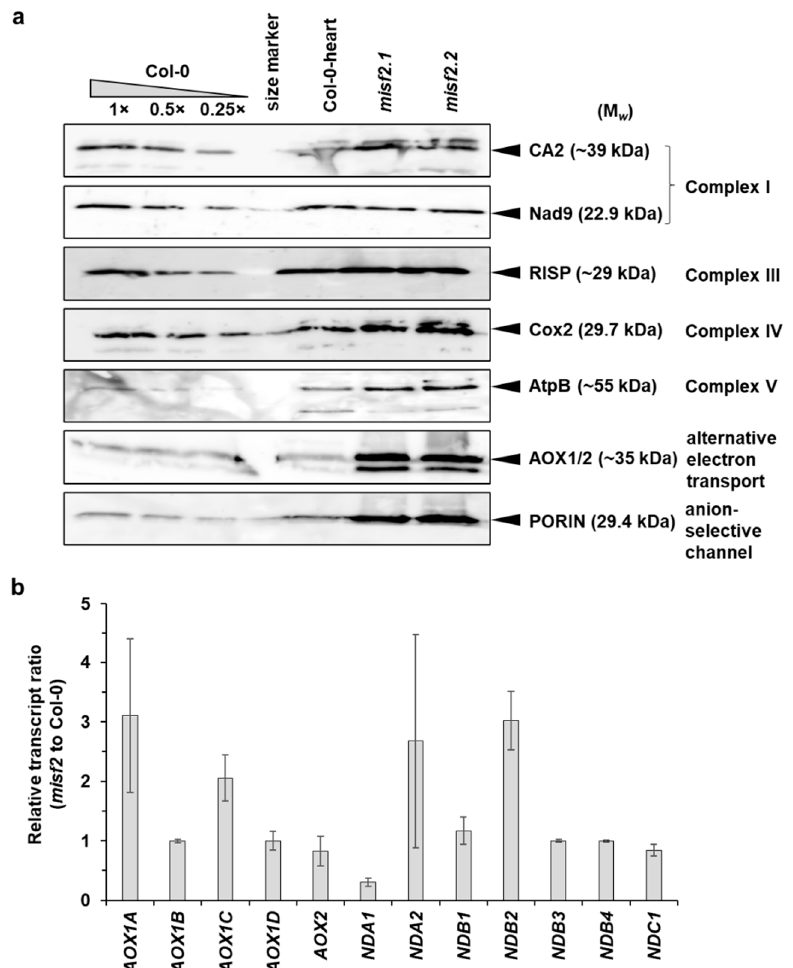
Figure 8. Relative accumulation of different mitochondrial proteins and AOX or ND transcripts in wild-type and misf2 plants. ( a ) Immunoblots made with crude organellar fractions (equivalent to ~40 mg FW) extracted from 3-week-old MS-grown wild-type plants, in vitro germinated wild-type embryos at the heart to torpedo stages (Col-0 torpedo), and homozygous misf2 plantlets. The blots were probed with antibodies raised against the indicated mitochondrial proteins. ( b ) Analysis of the steady-state levels of various alternative oxidase (AOX) and rotenone-insensitive NAD(P)H dehydrogenase (ND) mRNAs by RT-qPCR. The histogram displays relative mRNAs levels in misf2 plantlets to 3-week-old MS-grown wild-type plants.